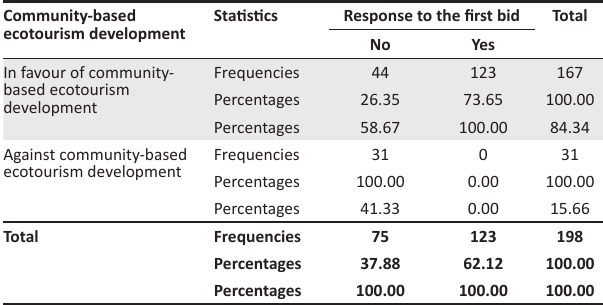
62.12 100.00 Percentages 100.00 100.00 100.00 Pearson chi 2 (3) = 5.2858, p -value = 0.152. Likelihood-ratio chi 2 (3) = 5.3812, p -value = 0.146. Fisher’s exact = p -value =